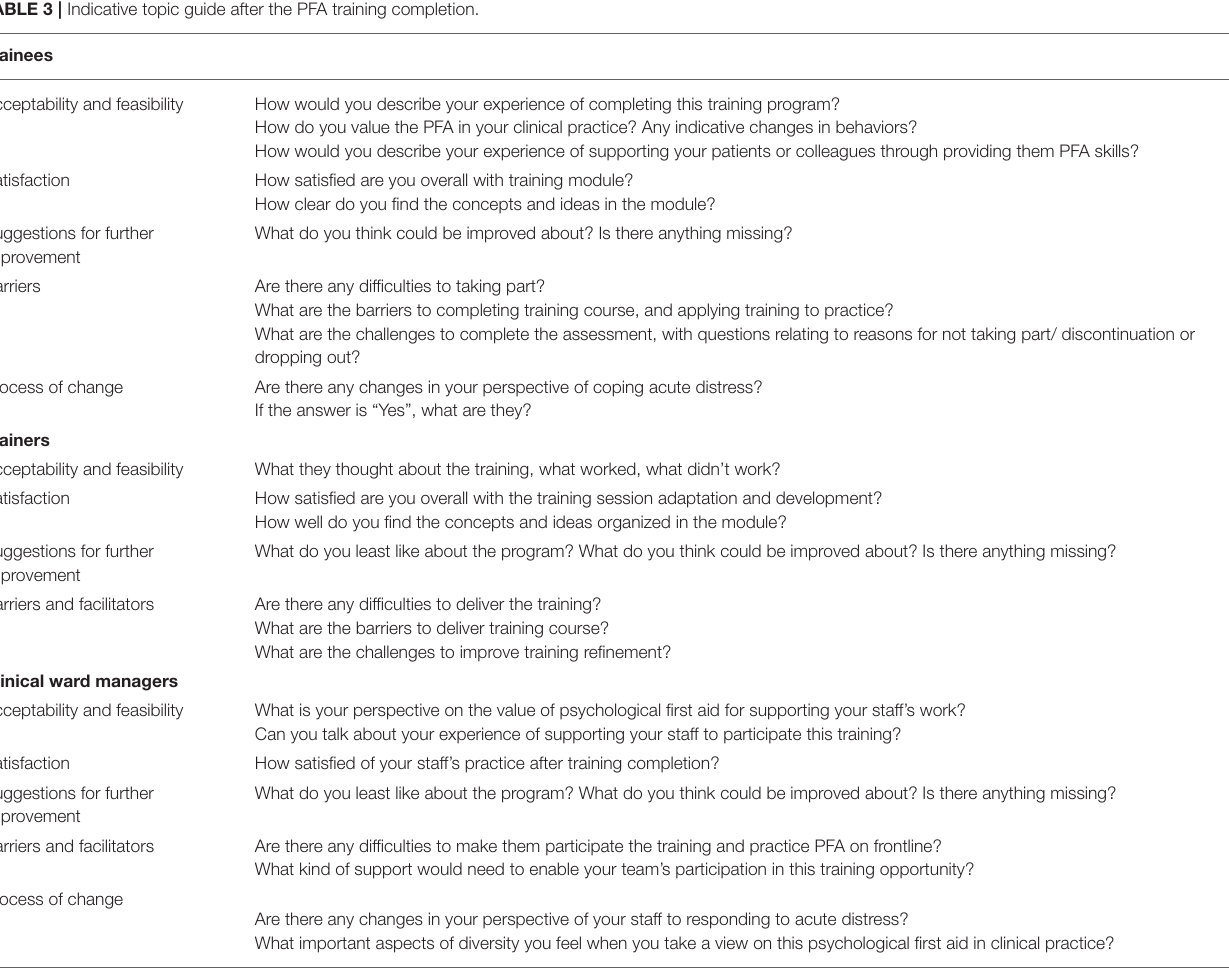
TABLE 3 | Indicative topic guide after the PFA training completion. Trainees